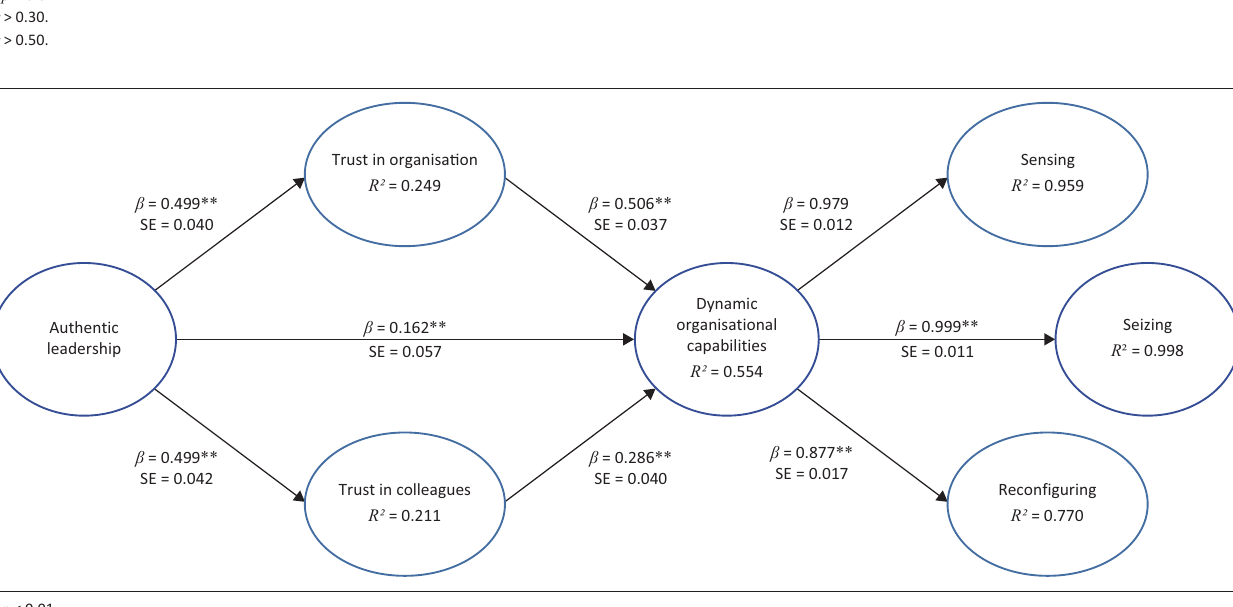
FIGURE 1: Standardised path coefficients for the best-fitting